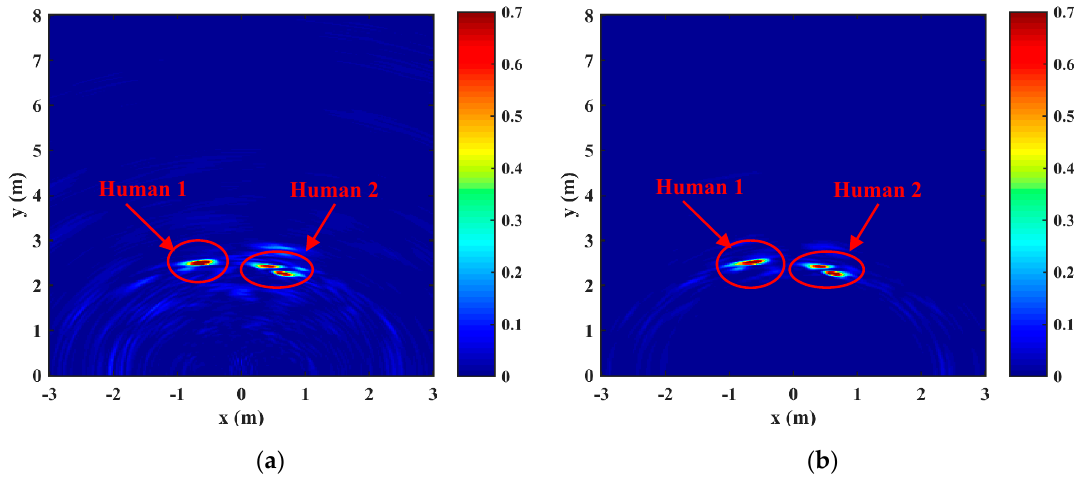
Figure 17. Imaging results obtained by the CC-TDBP algorithm with: ( a ) direct coupling removal; ( b ) background removal.